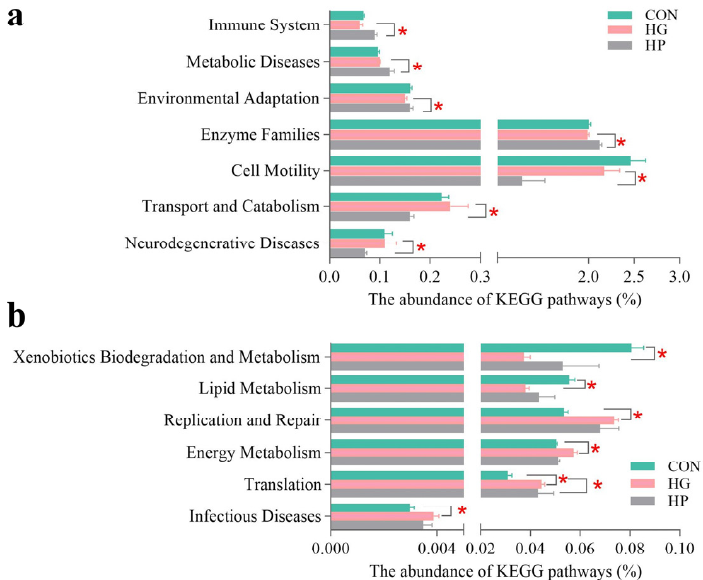
Figure 5. The alterations in the metabolic functions of jejunal digesta- ( a ) and mucosa- ( b ) associated microbiota at the KEGG level 2 in Hu sheep (n = 5) fed the CON, HG, and HP diets. CON, the control group; HG, the high-grain group; HP, the pelleted high-grain group. * p < 0.05.